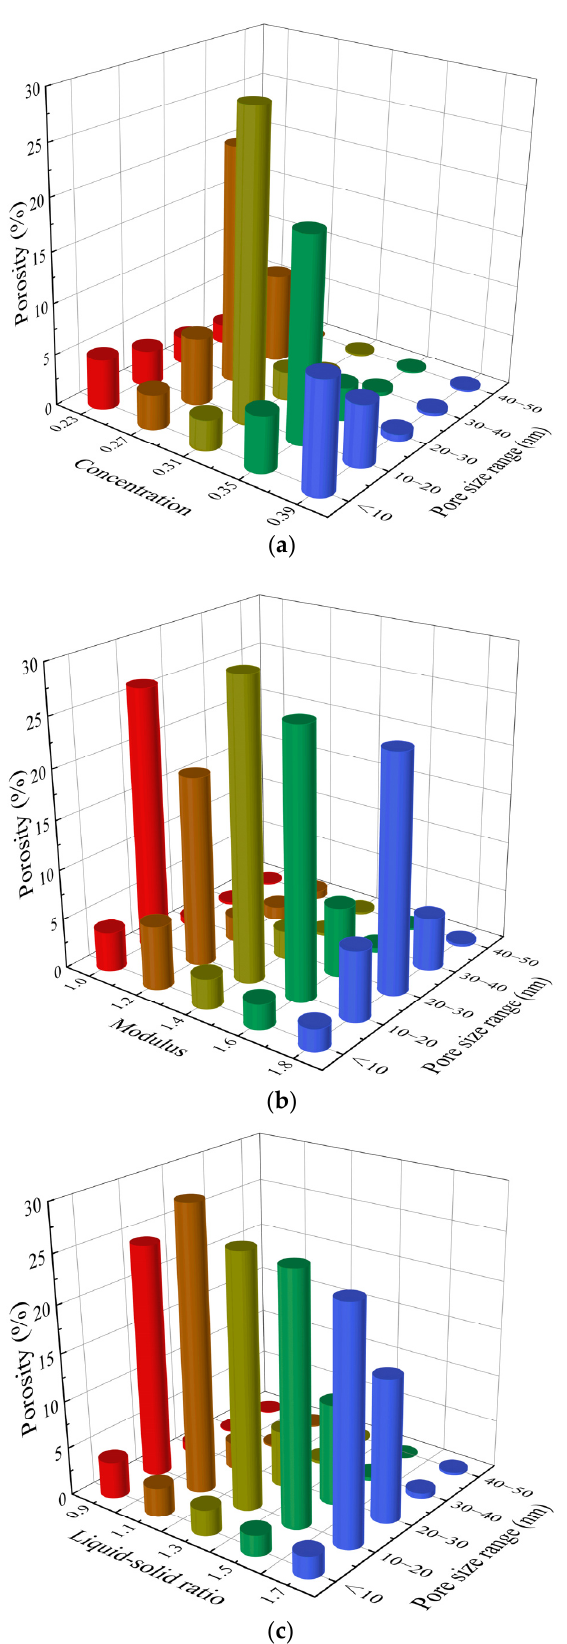
Figure 6. Porosity of pores smaller than 50 nm: concentrations ( a ), moduli ( b ), and L/S ratios ( c ). When the modulus and concentration are constant, the L/S ratio increases from 0.9 to 1.7, and the pores less than 10 nm in the paste change little, but the porosity of the pores in the range of 10~20 nm decreases by 31.4 %, and the porosity of the pores in the range of 20~30 nm increases by 10.7 times. This is because the effect of high L/S ratio on the pore structure characteristics of the MK-GGBFS geopolymer paste has two sides. On the one hand, the high L/S ratio leads to more water content in the system, which can provide more space for the depolymerization reaction of the mineral raw materials. The increase in alkali content and soluble silicate content can also promote the depolymerization reac- tion and provide more precursors for the polycondensation reaction. Therefore, the num- ber of reaction products increases and the reaction extent increases. This conclusion has been confirmed in Figure 2. On the other hand, more water content causes a larger initial distance between the precursors of the polycondensation reaction, and the resulting reac- tion product is not enough to fill the gap between the particles themselves [52,53]. More- over, excessive water is not consumed in the geopolymerization. As the reaction proceeds, water evaporates and leaves pores in the system [21]. The above two effects offset each other, and the influence of water content is dominant. Therefore, although the increase in L/S ratio can increase the reaction extent and the number of products, the pore becomes larger; Chotetanorm et al. [54] also found the same rules. 3.5. Morphology Analysis Figure 7 shows the SEM image of the MK/GGBFS-blended geopolymer pastes syn- thesized with varying concentrations, moduli of the alkaline activator, and L/S ratios, and all samples have unreacted mineral raw material particles and products with different morphologies. It can be seen from Figure 7a–c that the microstructure of the sample with the lowest concentration (C-0.23) is loose, and there are large interconnected pores be- tween the gel phase formed by the reaction and the unreacted mineral raw material par- ticles. In contrast, the gel phase in the microstructure of sample C-0.39 is the densest, which has small and disconnected pores and less unreacted mineral raw material parti- cles; this is consistent with the previous results that the higher the concentration, the smaller the porosity of geopolymer paste, the finer the pore size, and the higher the reac- tion extent. This is because with the increase in concentration, the alkali content and active SiO 2 content in the system increase, and the strong alkali can promote the depolymeriza- tion of the mineral raw materials, while the increase in active SiO 2 content promotes the formation of gel products and continuously fills the pores. The change of the modulus has the least effect on the microstructure of the samples (Figure 7d–f) because the samples M-